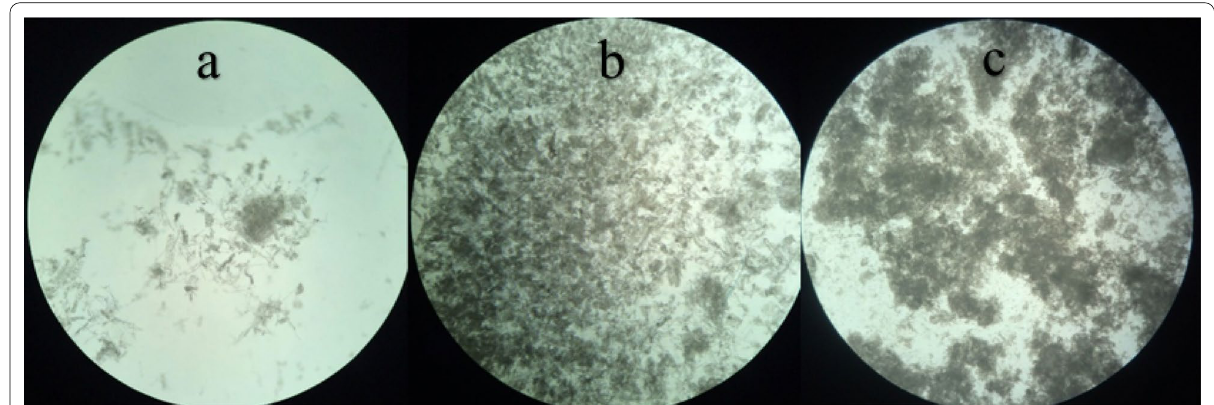
Fig. 7 The photography of the flocs formed by adding the cationic cellulose-based flocculant to the wastewater. The initial turbidities of a 20 NTU b 200 NTU, and c 500